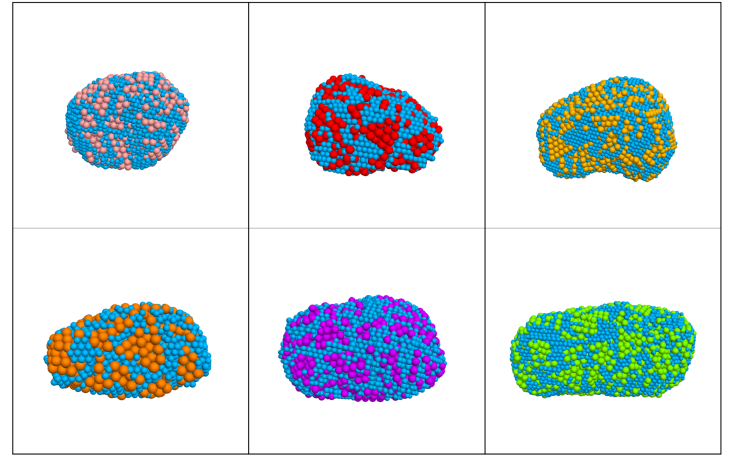
Figure 6. Morphology of the polymer–crystal composite particles in the DEM: blue balls are binders, and balls of other color are crystals.